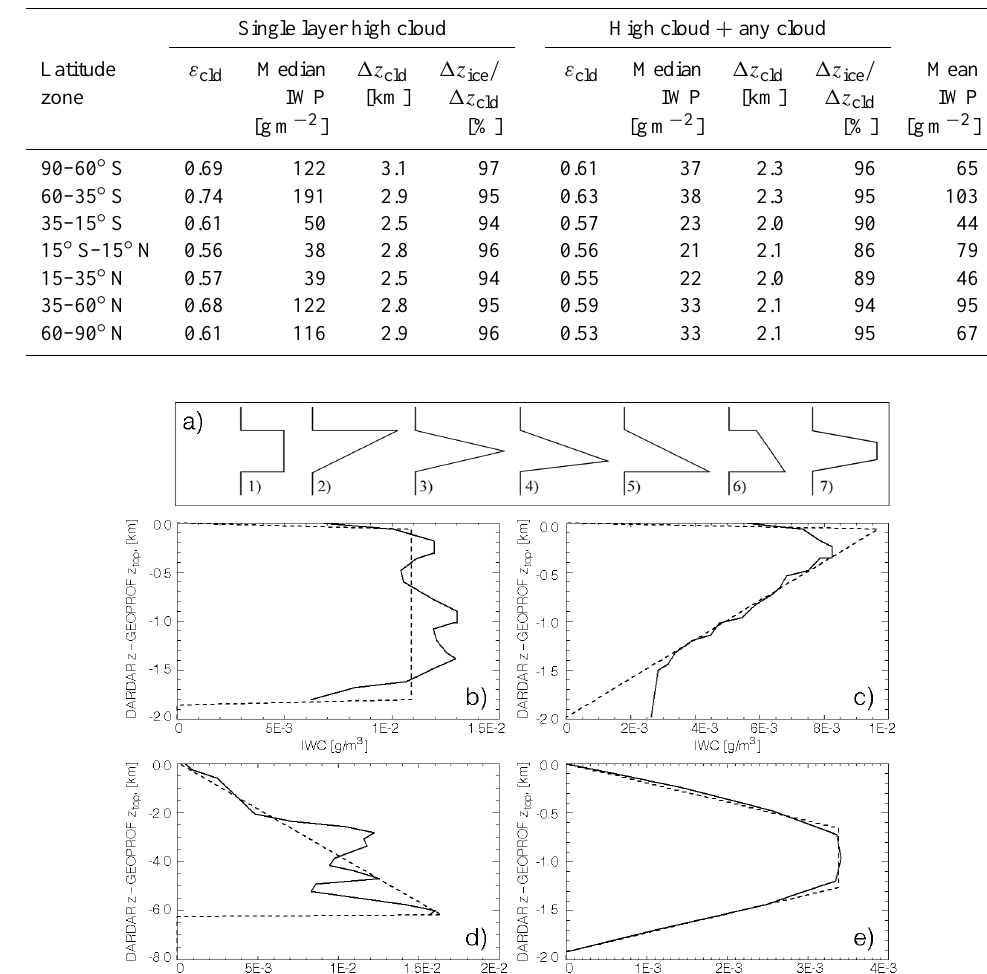
Table 3. Latitudinal averages of different ice cloud variables.